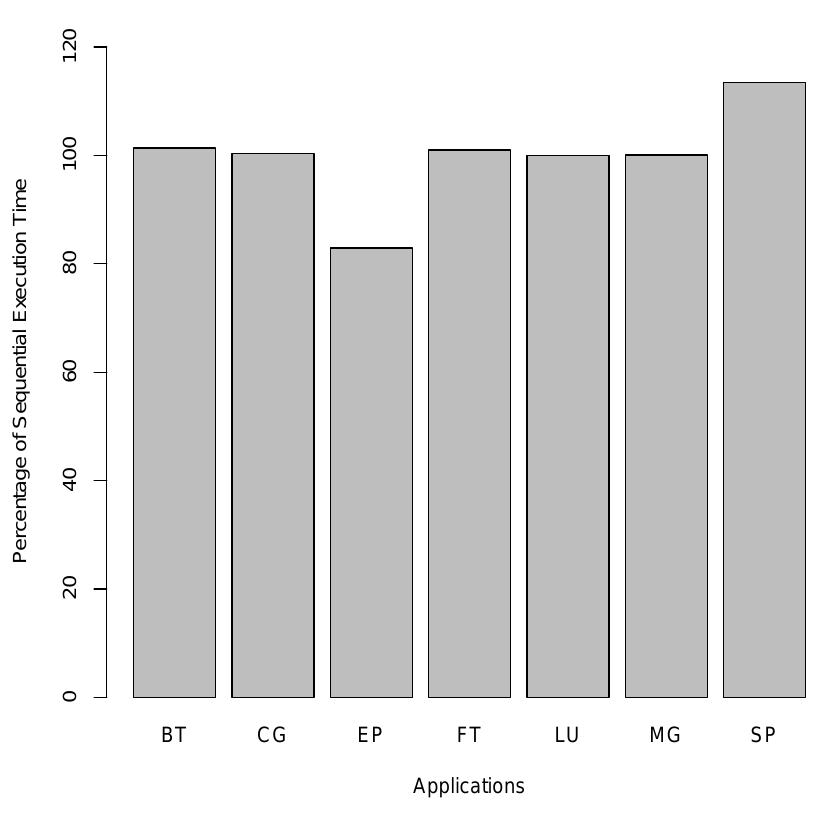
Figure 7: The performance of application optimisations using Four-Stage- Parallelisation